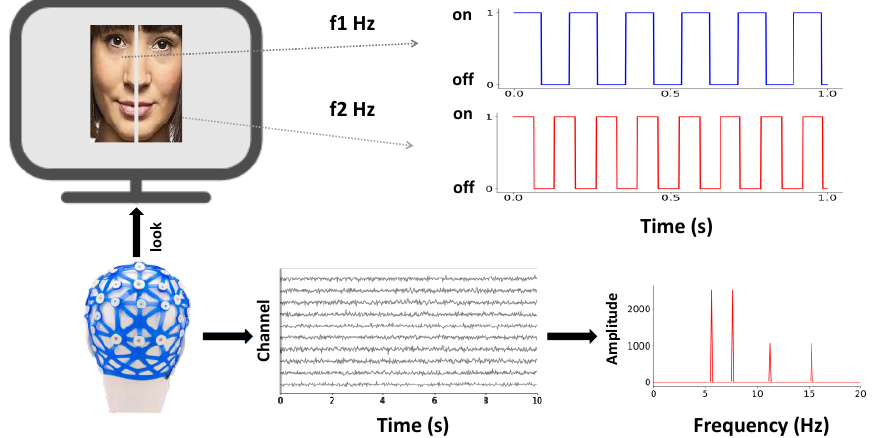
Figure 1. Principles of the application of IMs in perceptual integration research . In the study of IMs, the stimulus material generally contains two objects that change with time. Generally, these changing pictures can be periodic changes in brightness (two sine wave signals) or switching changes (two rectangular wave signals). When the subjects were watching these external signals, various signals of specific frequencies were generated in the brain in the form of neural oscillations. These signals contain not only the same periodic signal (fundamental frequency signal) as the external signal does, but also the interaction signal (harmonic signal and modulation signal) generated by the interaction of the signals. By analyzing the EEG signal in the frequency domain, all components of the signal can be obtained. Therefore, the IM approach is a more direct and effective tool for measuring neural interaction at present.